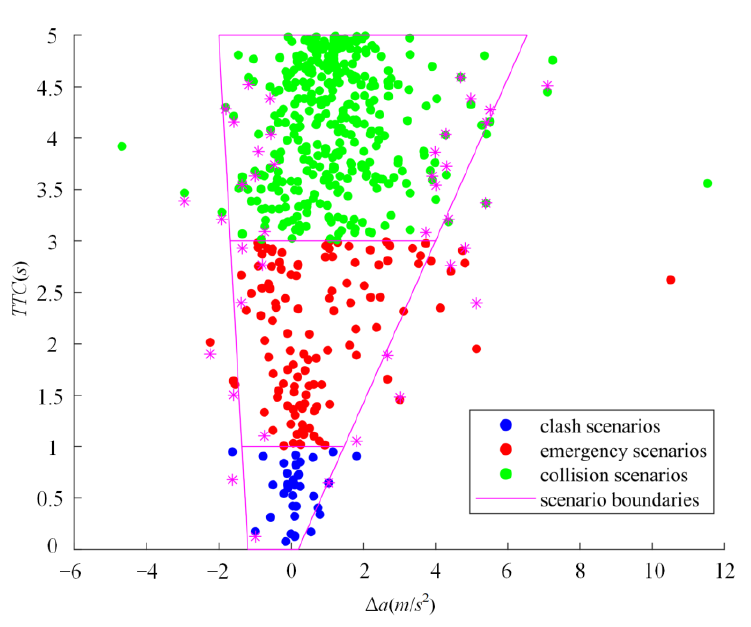
Figure 13. The scenario boundaries of NDD based on the joint distribution of TTC and ∆ a . Critical scenarios are divided into multiple intervals by TTC , and extreme points of each interval marked with magenta are solved according to ∆ a . Extreme points are used as control points to solve scenario boundaries based on SVR. Both maximum and minimum points are taken as the input of SVR, and the linear kernel is used as the kernel function. Scenario boundaries are obtained in Figure 13, and areas enclosed by these boundary boxes represent conflict, emergency, and crash scenario regions, respectively, while the remaining area represents the safe scenario region.